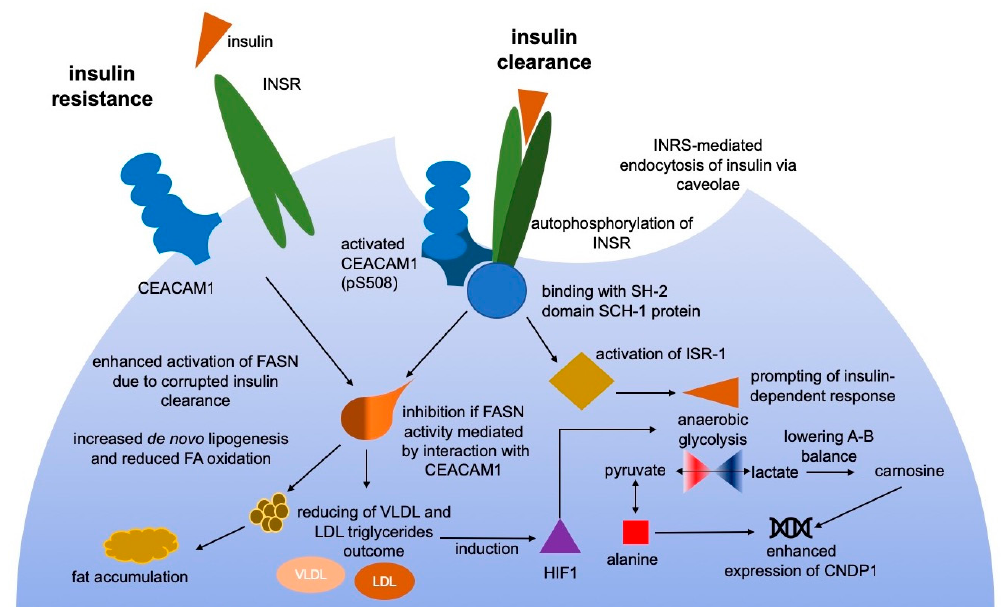
Figure 4. The proposed mechanism of insulin resistance in patients with T2DM and GDM. During uncomplicated pregnancy, CEACAM1 reaches the highest concentration in the third trimester [49]. Binding of insulin to INSR receptors promotes their autophosphorylation and downstream activation of CEACAM1 at position pSer508 and insulin-substrate receptor-1 (ISR-1) that enhances endocytosis of insulin [50,51]. Activated CEACAM1 may bind to the SH-2 domain-containing SCH-1 phosphatase leading to limitation of its activity and, thus, prolonging the phosphorylated state of CEACAM1. This entails to inhibition of fatty acid synthase (FASN) and increasing insulin-mediated response [52,53].